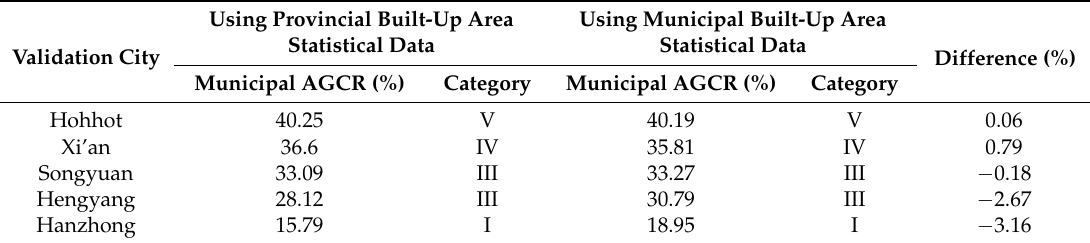
Table 4. The difference between the municipal AGCR estimate results using provincial and municipal built-up area statistical